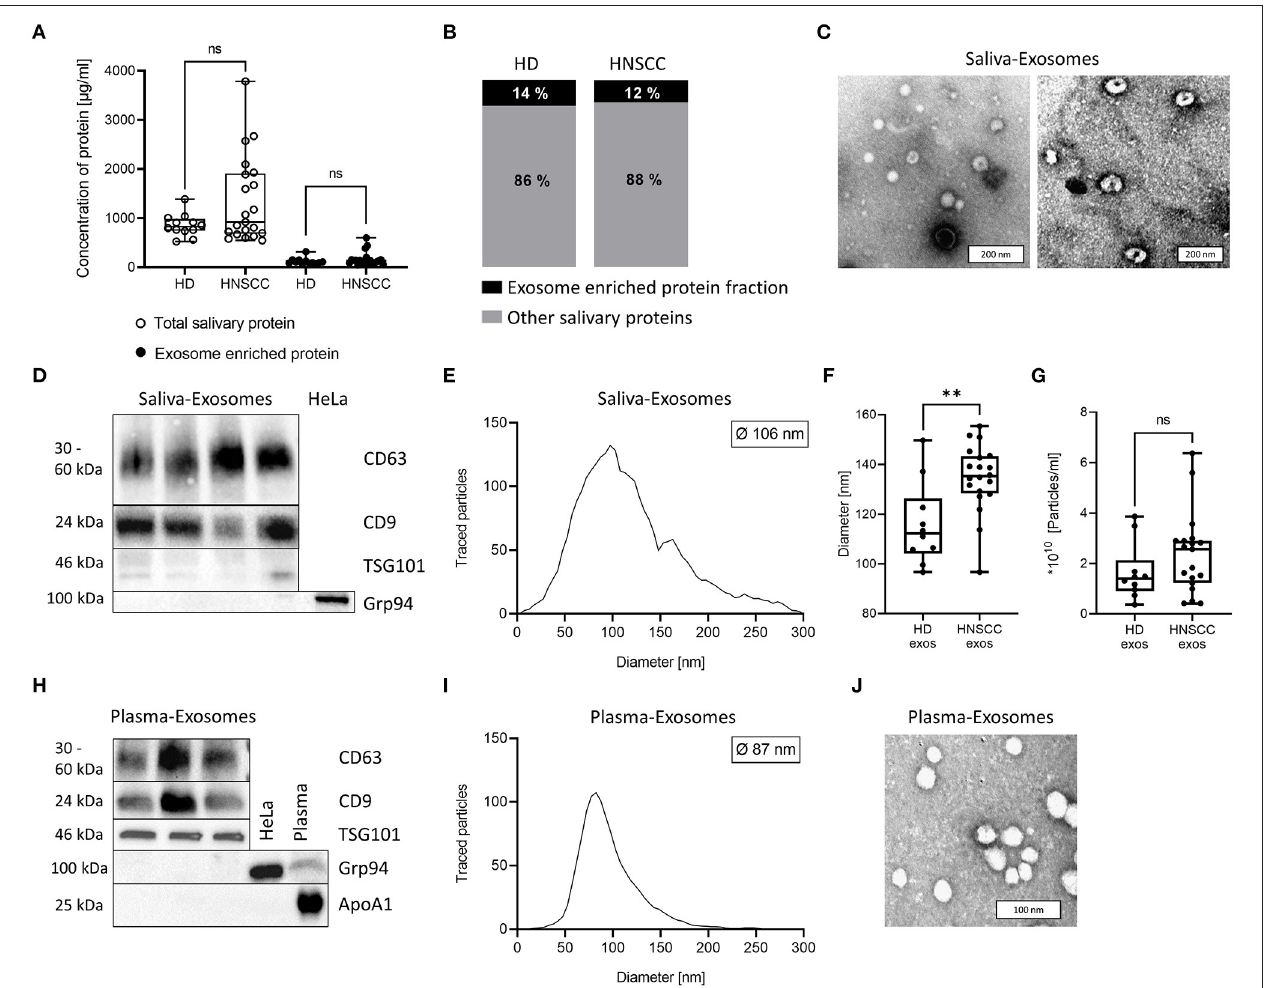
FIGURE 1 | Characterization of exosomes isolated from human saliva and plasma. (A) Total salivary protein and exosome enriched protein obtained from saliva of healthy donors (HD; n = 12) and head and neck squamous cell carcinoma (HNSCC) patients ( n = 21). (B) The ratio between exosome enriched protein and total saliva protein was determined for each sample and average percentage is shown for HD and HNSCC patients. (C) Representative transmission electron microscopy (TEM) images of exosomes derived from saliva of one HNSCC patient (left) or HD (right). (D) Western blot for detection of exosomal markers CD63, CD9, TSG101 and the cellular marker Grp94 in saliva-derived exosome preparations. HeLa-cell-lysate was used as a positive control for Grp94. (E) Nanoparticle tracking analysis (NTA) of saliva-derived exosomes. The histogram shows a representative size distribution of saliva-derived vesicles with a median diameter of 106nm. (F) Exosomes from saliva of HNSCC patients showed a higher median diameter ( n = 20, 135nm) compared to exosomes from saliva of HD ( n = 10; median diameter 116nm). (G) Concentration of detected vesicles/ml was analyzed by NTA and compared between HD ( n = 10) and HNSCC patients ( n = 19). (H) Western blot for detection of exosomal markers CD63, CD9, TSG101, the cellular marker Grp94 and contaminant apolipoprotein ApoA1 in plasma-derived exosome preparations. HeLa-cell-lysate and plasma were used as a positive control for Grp94 and ApoA1, respectively. (I) NTA of plasma-derived exosomes. The histogram shows a representative size distribution of plasma-derived vesicles with a median diameter of 87nm. (J) Representative TEM image of HNSCC patient’s plasma-derived exosomes. (A,F,G) Results are plotted as box-and-whisker blots representing the median value, the 25 th and 75 th quartiles and the range. P -values were determined by Mann–Whitney test, ** p ≤ 0.01, *** p ≤ 0.001, ns, not